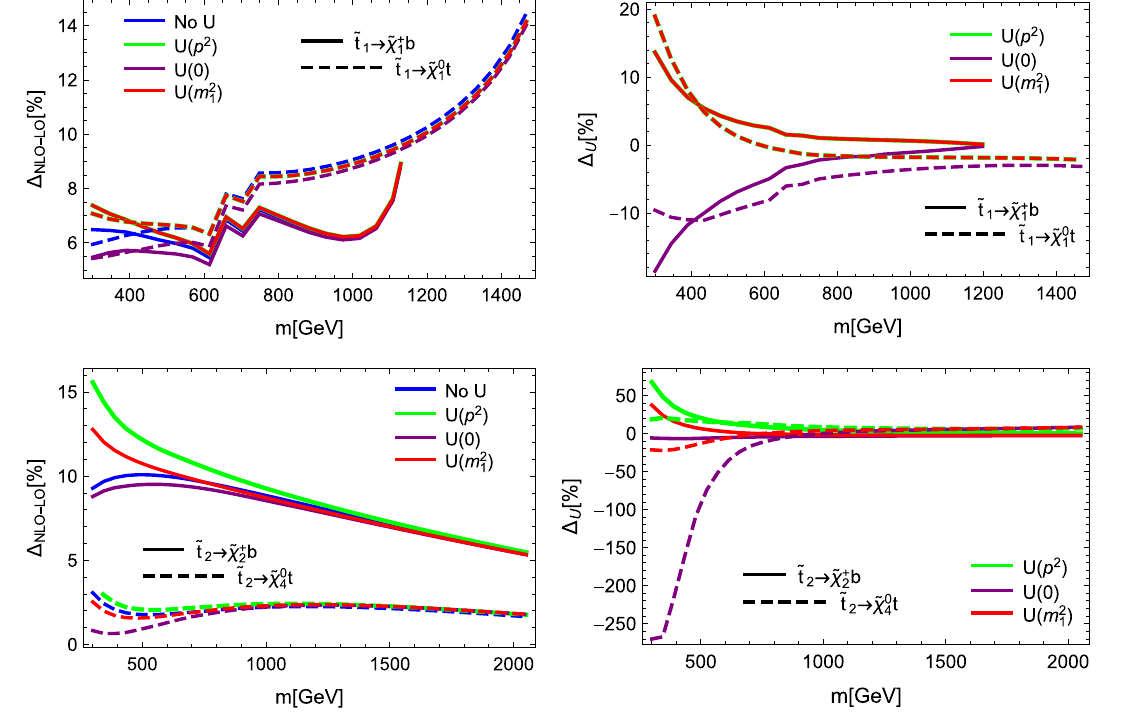
Fig. 10 Same as Fig. 9 for decays of